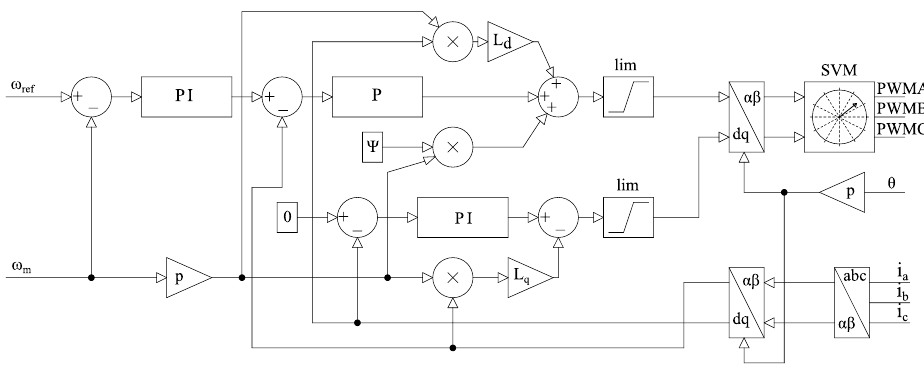
Figure 5. Schematic of the